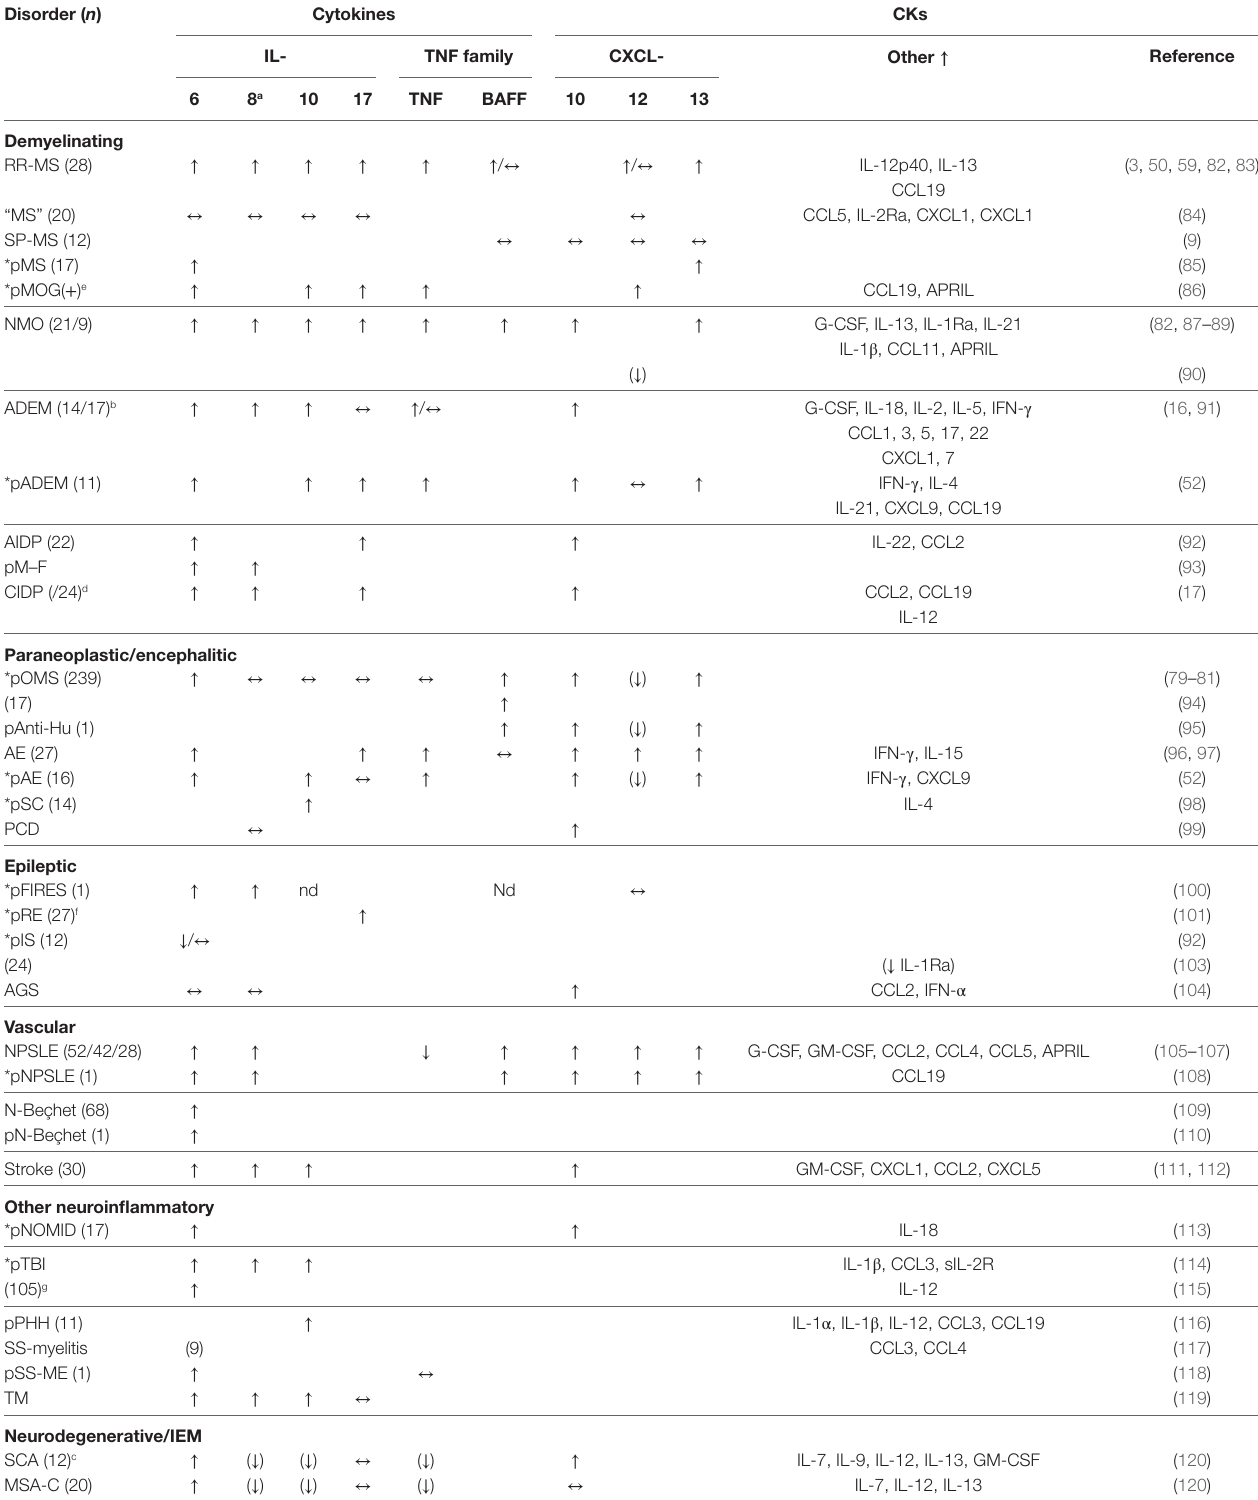
TABle 5 | CSF chemo/cytokine biomarker signatures in key neuroinflammatory disorders. Disorder ( n